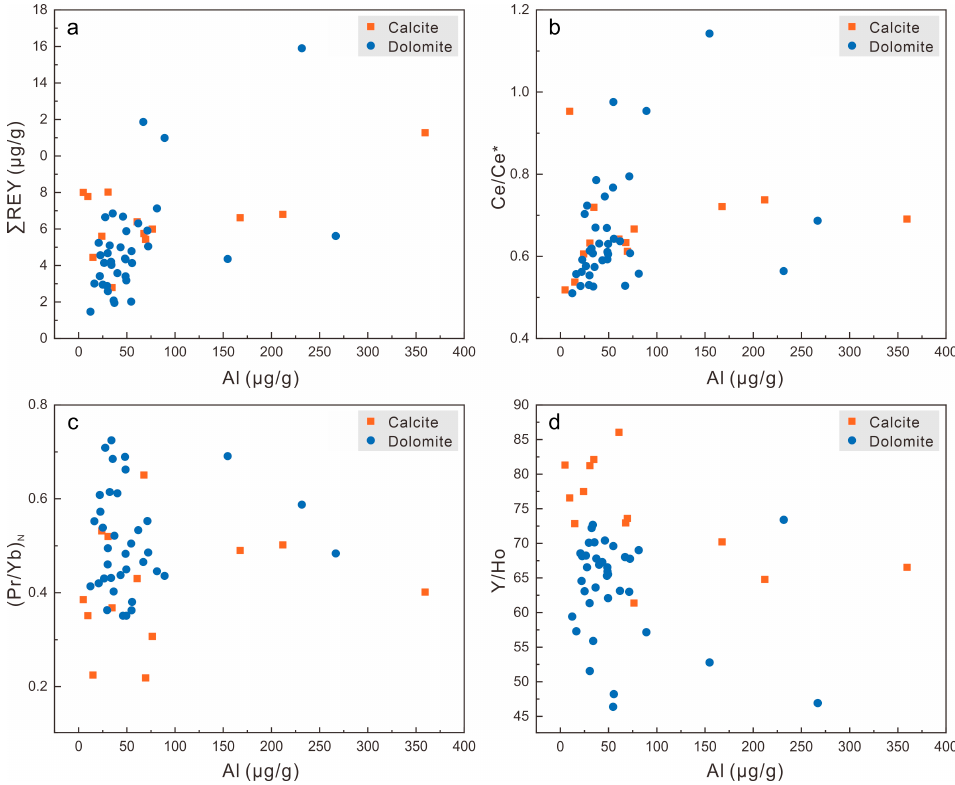
Figure 5. ( a ) ∑ REY, ( b ) Ce/Ce * , ( c ) (Pr/Yb) N , and ( d ) Y/Ho vs. the Al concentration in the XK-1 core carbonates. For both calcite and dolomite samples, the Al concentration does not show any correlations with the values of REY proxies.